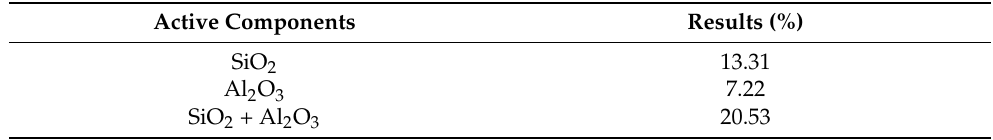
Table 3. The assessment of pozzolanic activity of fly ash used by chemical